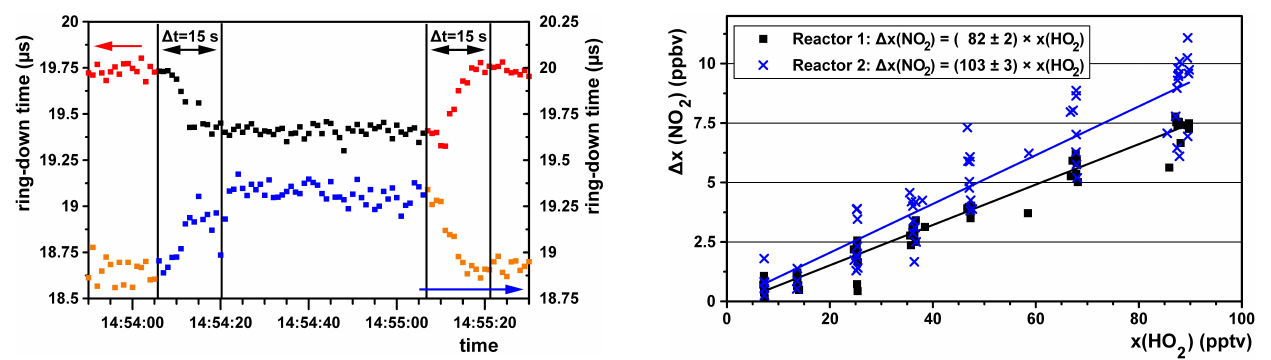
Fig. 12. Switching between background (reactor 1: left y axis, red; reactor 2: right y axis, blue) and amplification mode (reac- tor 1: left y axis, black; reactor 2: right y axis, orange); the two solid lines indicate a time difference of 15s required for the gas flow stabilization.